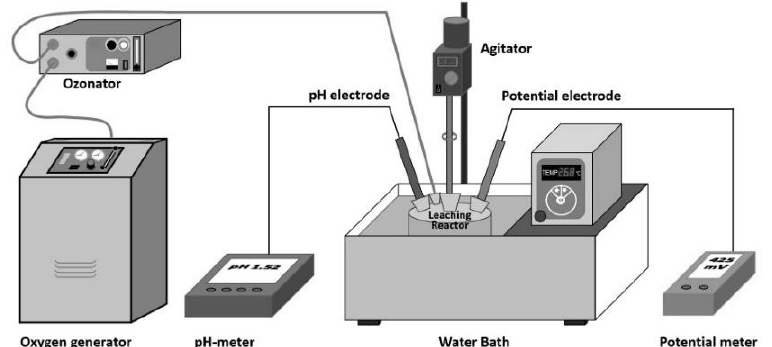
Figure 1. Experimental setup.